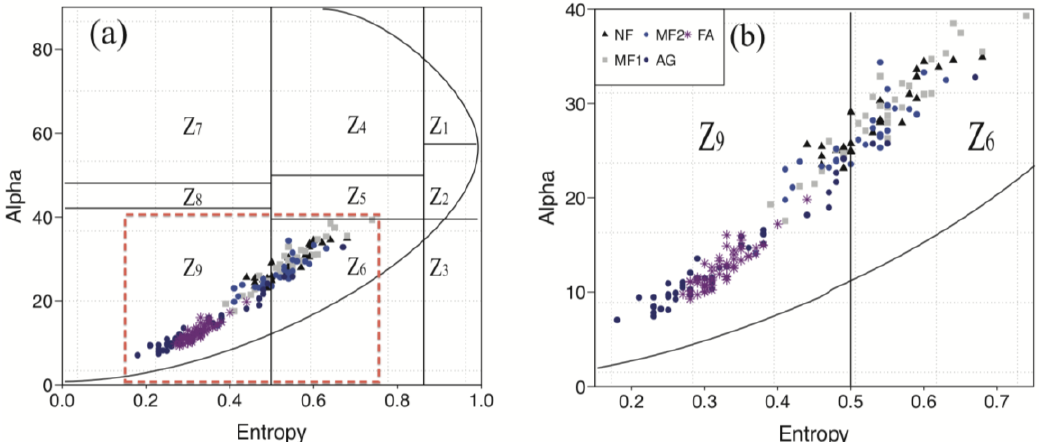
Figure 4. ( a ) Alpha-Entropy decomposition ( 𝑍 scattering, 𝑍 , 𝑍 and 𝑍 by volume scattering, and 𝑍 2 5 8 mechanism. 𝑍 is non-feasible region). Dashed red polygon shows the extent of Figure 4b; 3 ( b ) The zoomed view of the distribution of training dataset on the Alpha-Entropy plane. The results are based on the training dataset. See Table 1 for the descriptions of classes.